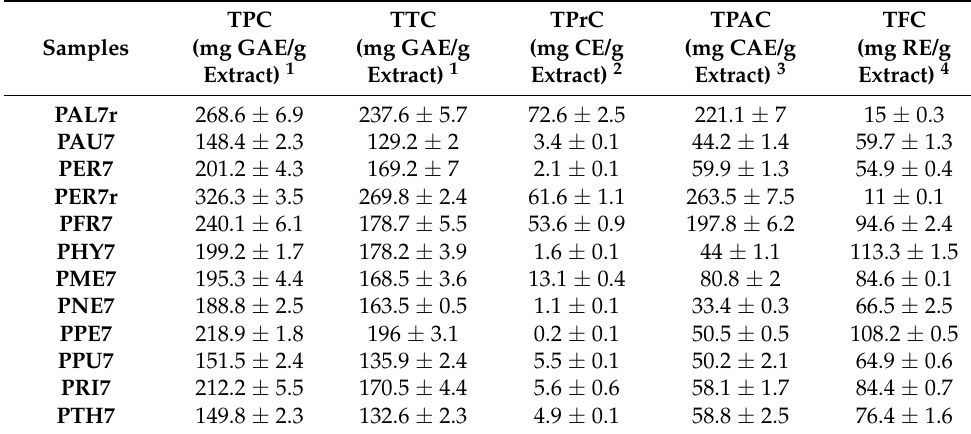
Table 1. Total phenolic (TPC), tannin (TTC), proanthocyanidin (TPrC), phenolic acid (TPAC), and flavonoid contents (TFC) of aqueous acetone